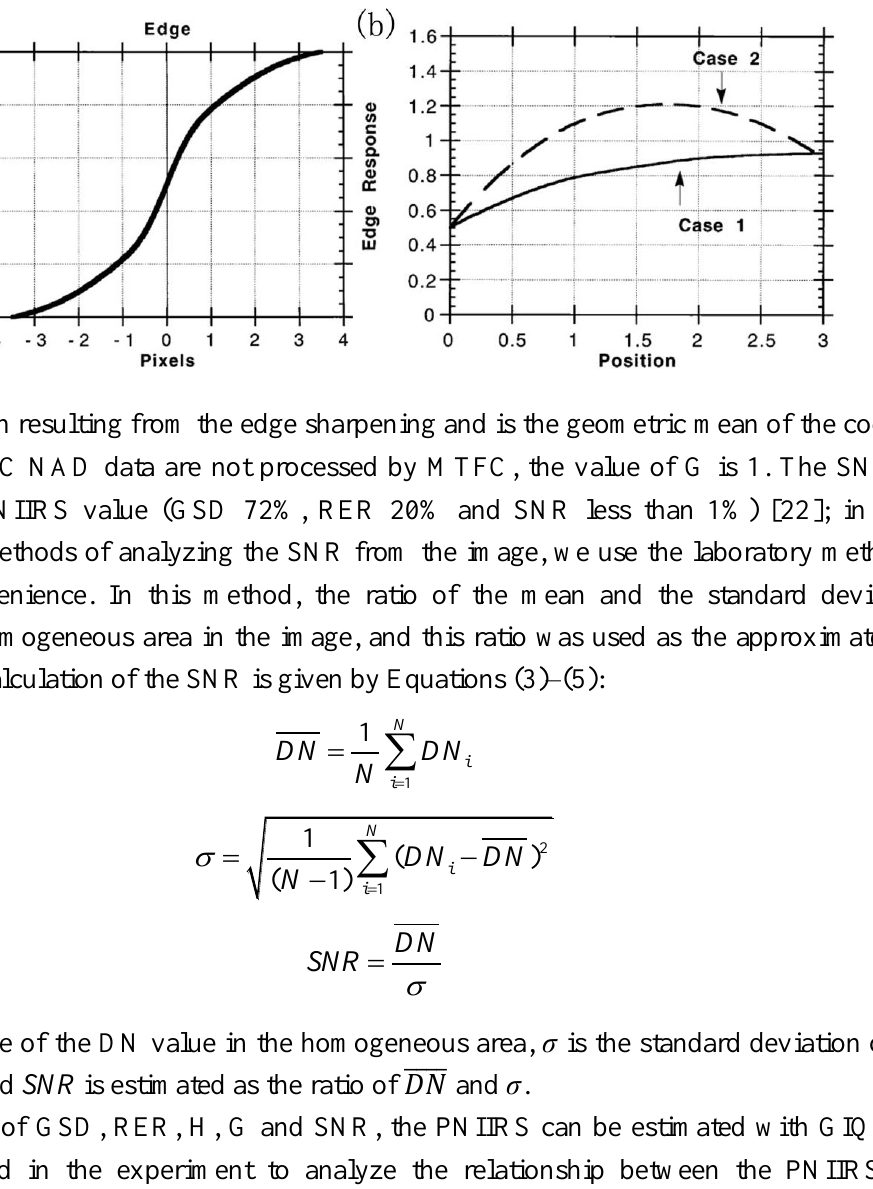
Figure 3. ( a ) The measurement of RER. ( b ) The measurement of H. The edge in Case 1 is monotonically increasing, the H is defined as the value at 1.25 pixels from the edge. Case 2 is not monotonically increasing, the H is the maximum value in the pixel range of +1 to +3